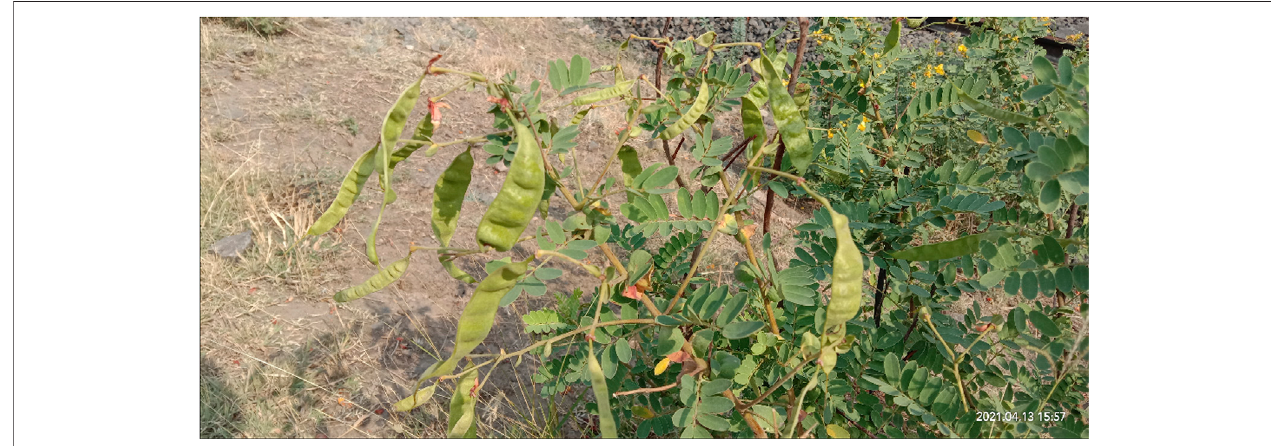
FIGURE 2 | Fruits & Leaves of Senna auriculata (L.)